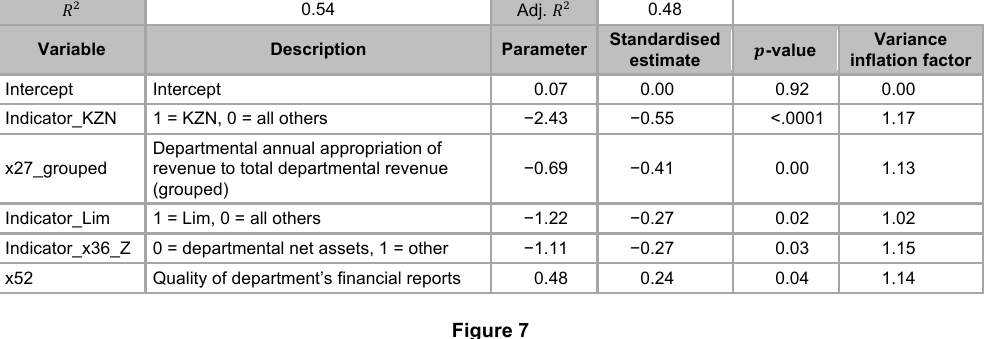
Residual plots of the H data set’s backward and best subset